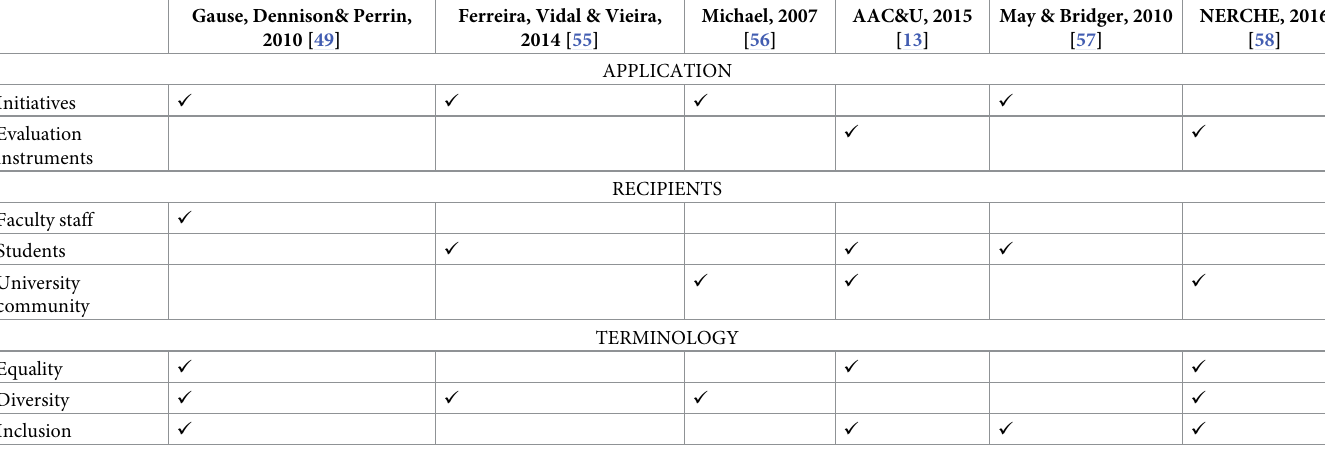
Table 1. Differences between the evaluation proposals of the institution’s commitment to equality, diversity and inclusion. Gause, Dennison& Perrin, 2010